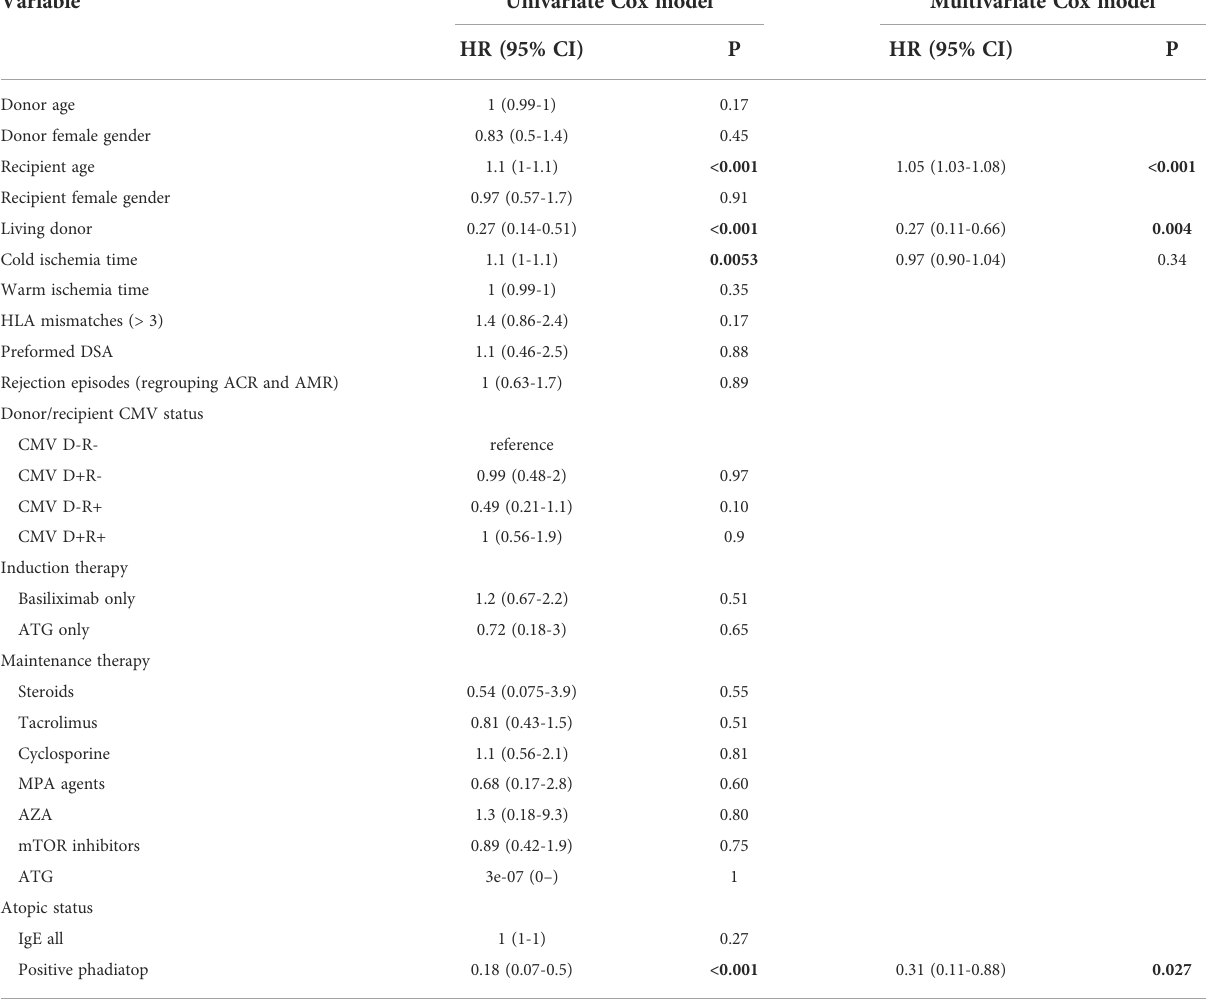
TABLE 2 Risk factors for patient mortality during